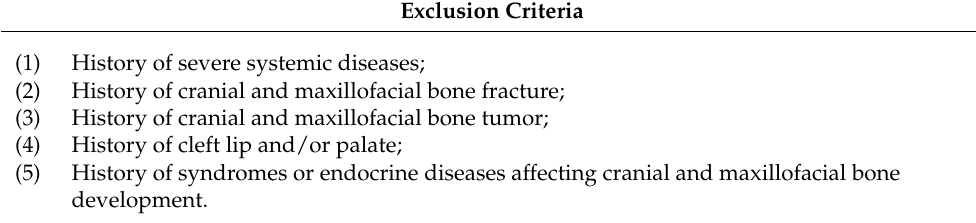
Table 1. Exclusion criteria for